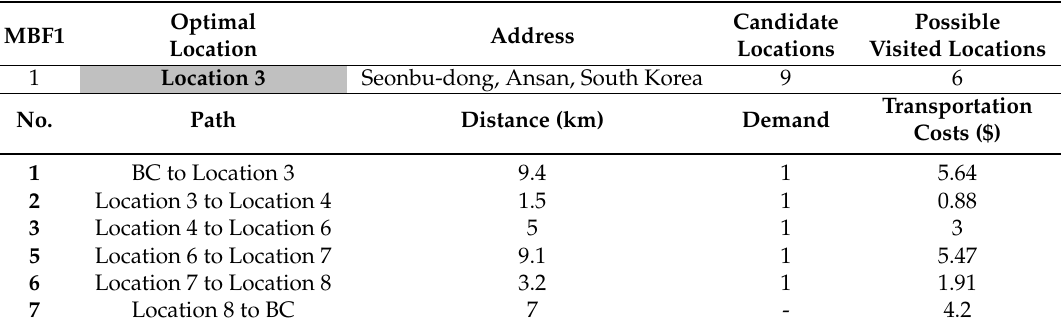
Table 5. The optimal location and navigation path of MBF1.